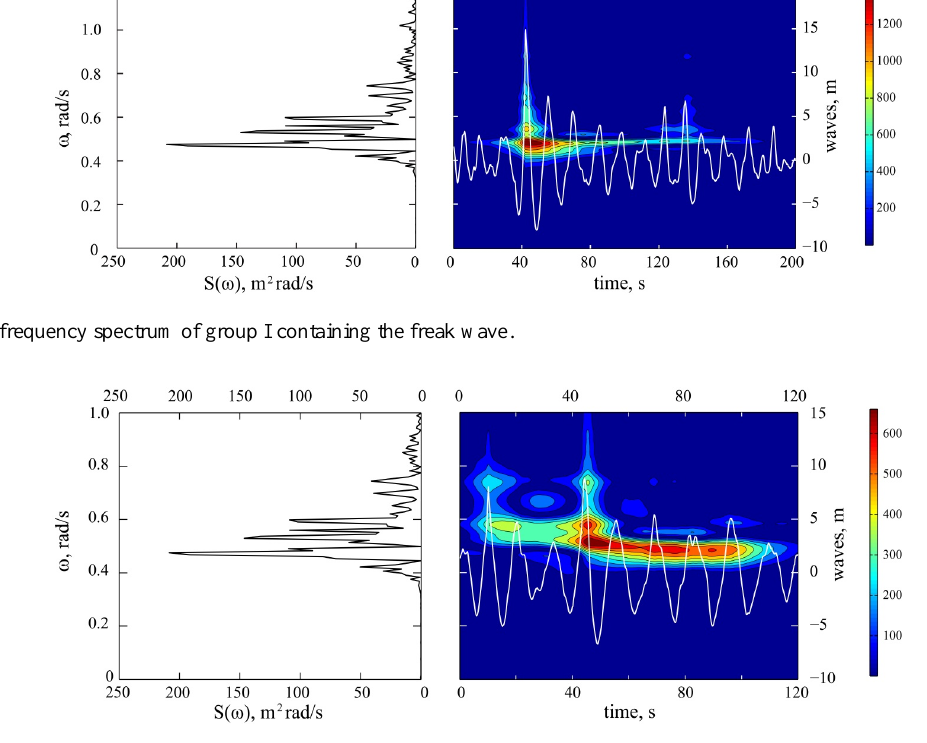
distribution. Spectrum and time–frequency spectra are calcu- lated with same frequency